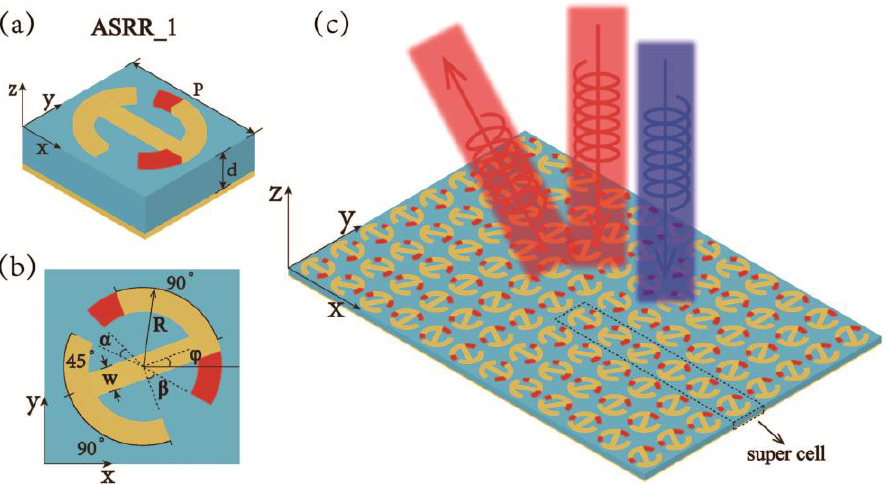
Figure 1. Schematic of ( a ) the electromagnetic responses of a gradient chiral metamirror and ( b , c ) the structure of a unit cell.